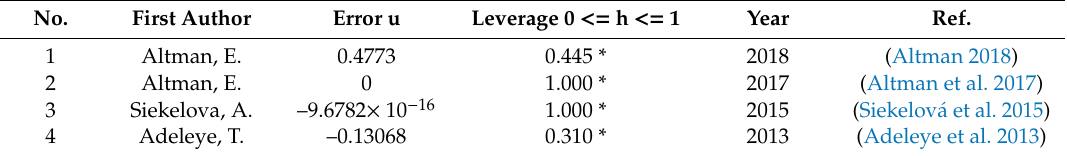
Table 6. Leverage papers.